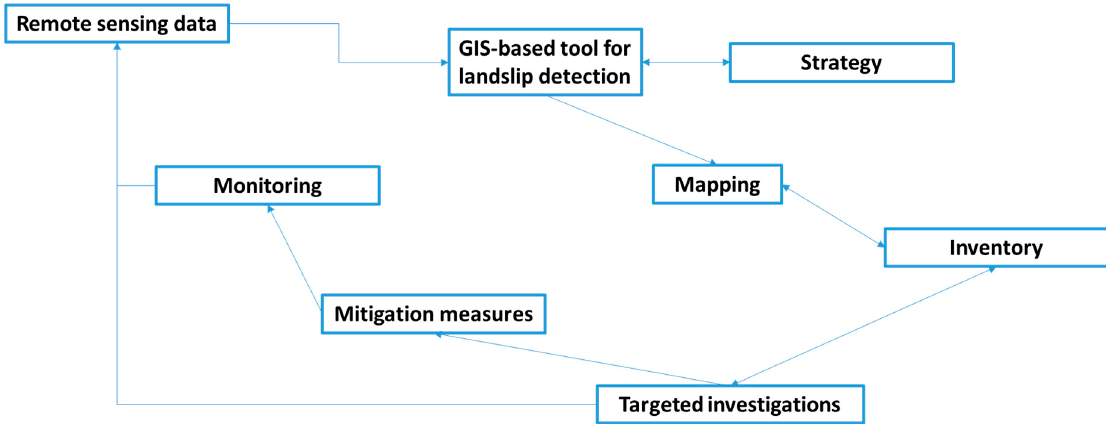
Figure 9. The application of the new proposed GIS-based tool for landslip detection within the process for management of slope instability.